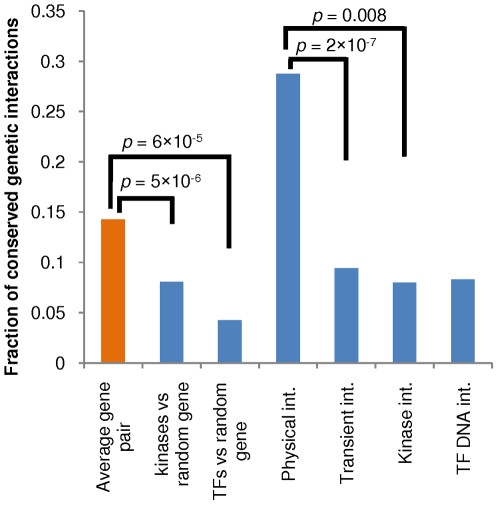
Functional divergence of protein kinases and transcription factors.Genetic interactions were compiled for orthologous gene pairs in S. cerevisiae and Sc. pombe. We compared the level of conservation of genetic interactions involving protein kinases and transcription factors to the average conservation of S. cerevisiae genetic interactions. The conservation of genetic interactions that overlap with protein–protein interactions were compared with physical interactions involving at least one protein kinase and with transient interactions. Physical interactions were defined as transient if they were experimentally determined by methods capable of capturing transient interactions (see Methods). The number of conserved interactions for each category is as follows: average gene pairs: 761 out of 5,322; kinases versus random genes: 38 out of 472; TFs versus random genes: 6 out of 141; physical interactions: 67 out of 233; transient interactions: 8 out of 85; kinase interactions: 2 out of 25; TF–gene interactions: 4 out of 48.